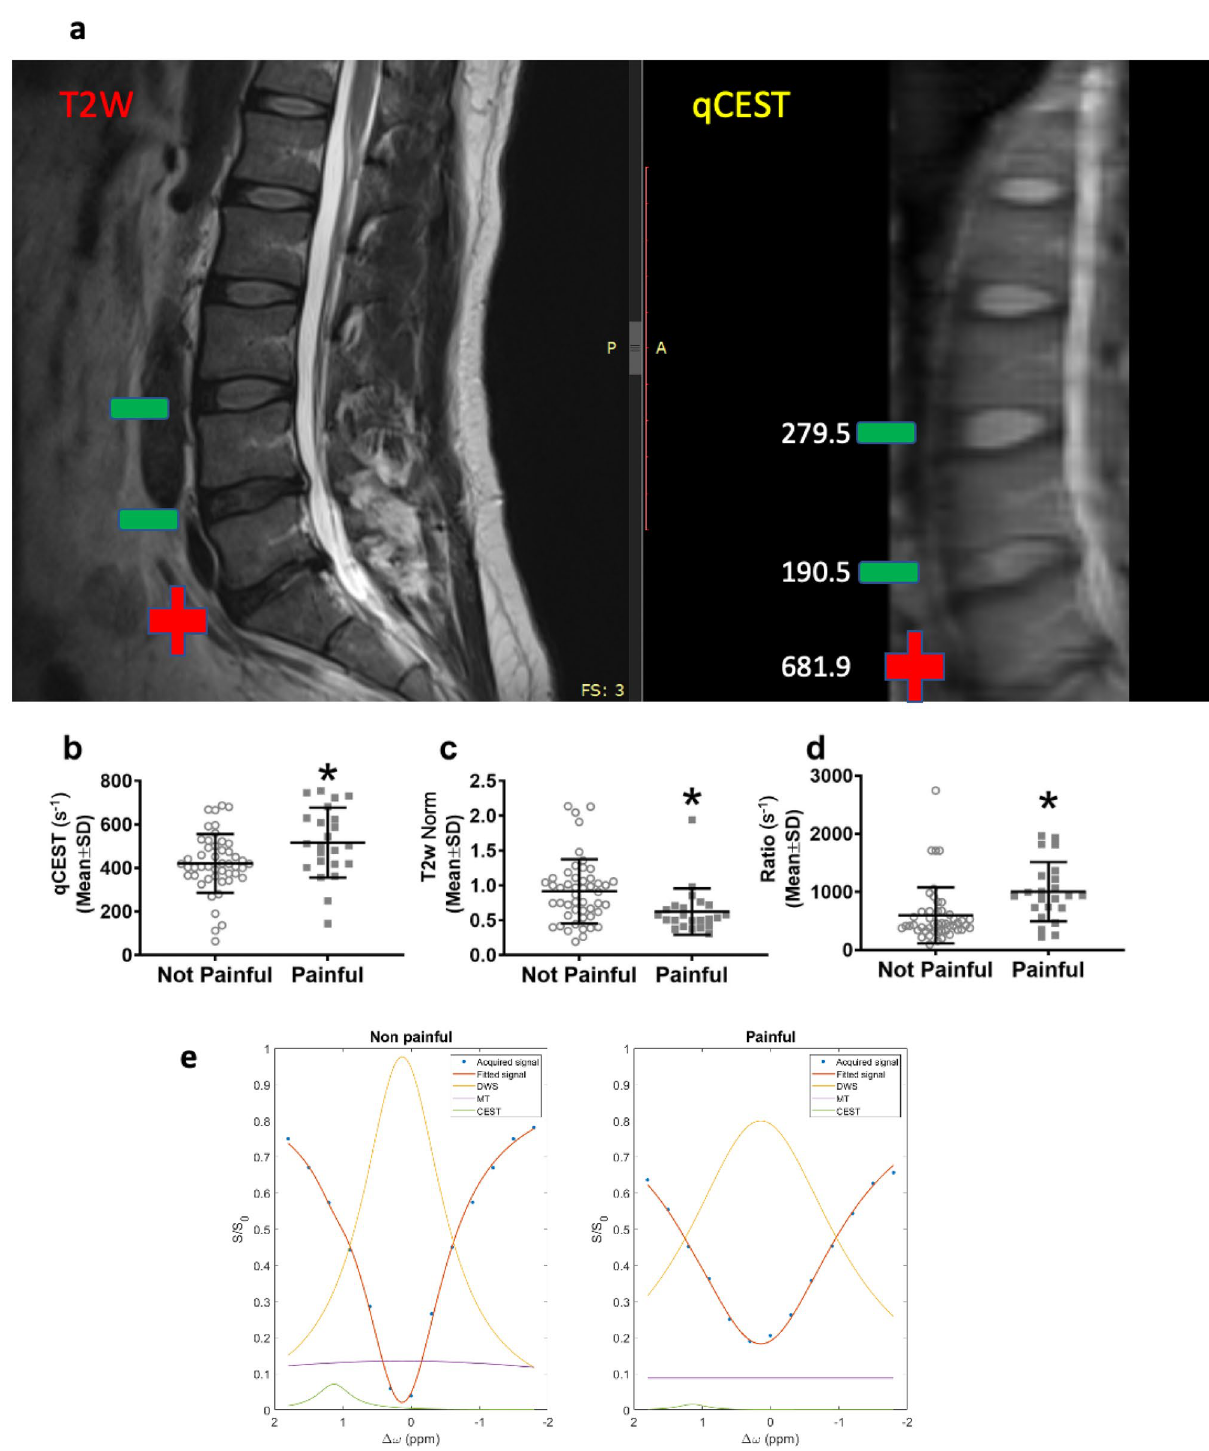
Figure 3. QCEST, T2W and qCEST/T2W ratio values were significantly different between painful and non-painful discs. Representative T2W and qCEST MRI scans of a human patient showing a disc that was determined painful in PD (+) and discs that were non-painful in PD (−). qCEST values are indicated for each disc ( a ). The average qCEST value of painful discs was significantly higher than non-painful discs ( p = 0.012; b ). The average normalized T2w value of painful discs was significantly lower than non-painful discs ( p = 0.0091; c ). The ratio between qCEST and normalized T2w was calculated for each disc and was found to be significantly higher in painful discs compared to non-painful discs ( p = 0.0022; d ). (n = 72 discs). Representative Z-spectra (acquired at saturation flip angles of 900 or effective B 1 = 0.73 µT) of painful (L5/S1) and non-painful (L3/L4) discs ( e ) (Norm =